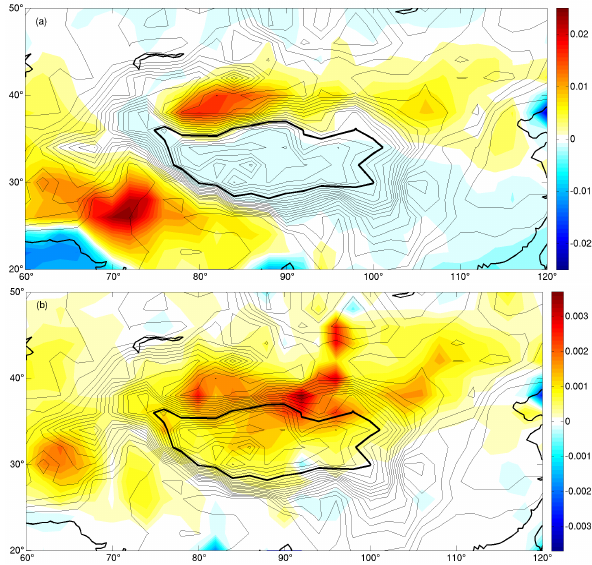
Fig. 12. Effect of albedo variations on aerosol forcing ( 1 alb ) in vertically averaged total heating rates between (a) 0 and 5km and (b) 5 and 8kma.m.s.l. in K/day. Note the different scalings of the colorbars, each time adjusted to the respective extreme value. The thick lines indicate coasts and the Tibetan